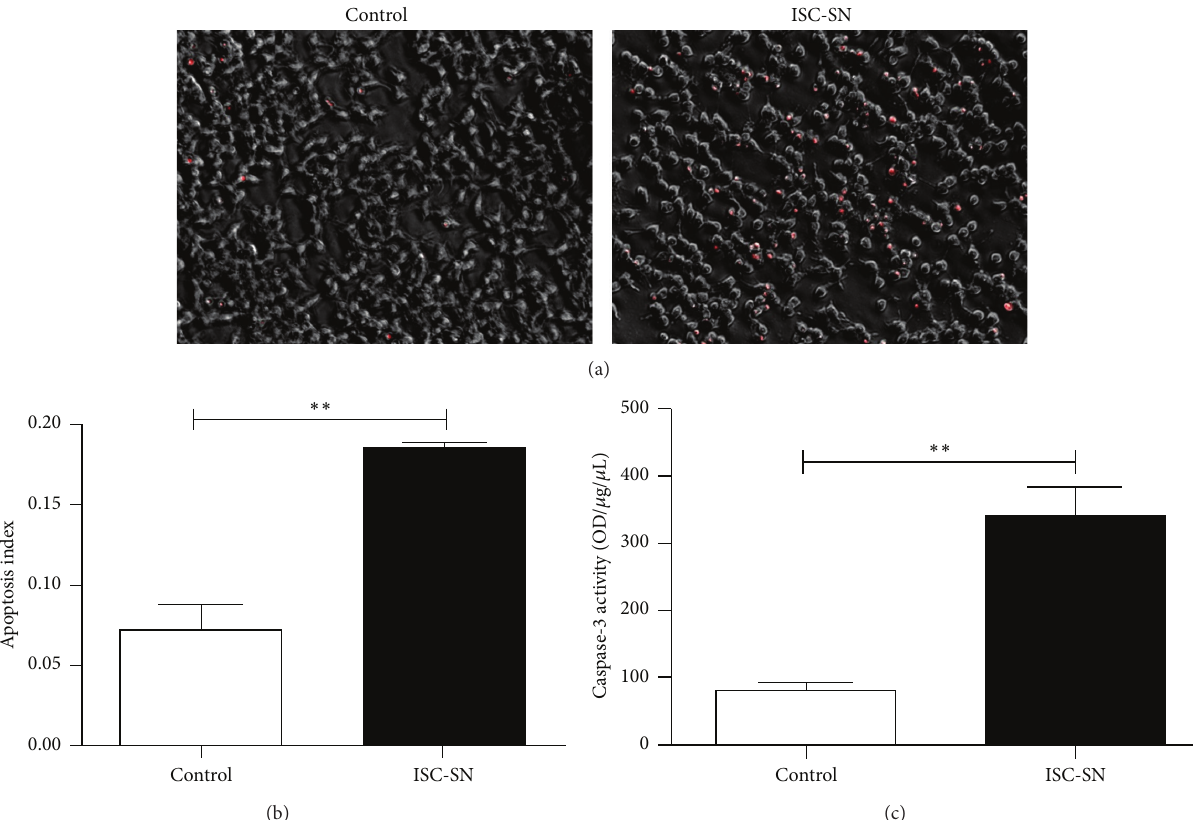
Figure 4: Effect of ISC-SN on INS-1 cell apoptosis. (a) Cell apoptosis was determined by PI staining (red), (b) PI-staining index, and (c) caspase-3 activity in INS-1 cells cultured with ISC-SN for 48 h. Data are expressed as mean ± SE ( 𝑛 = 3 ), ∗∗ 𝑃 < 0.01 .